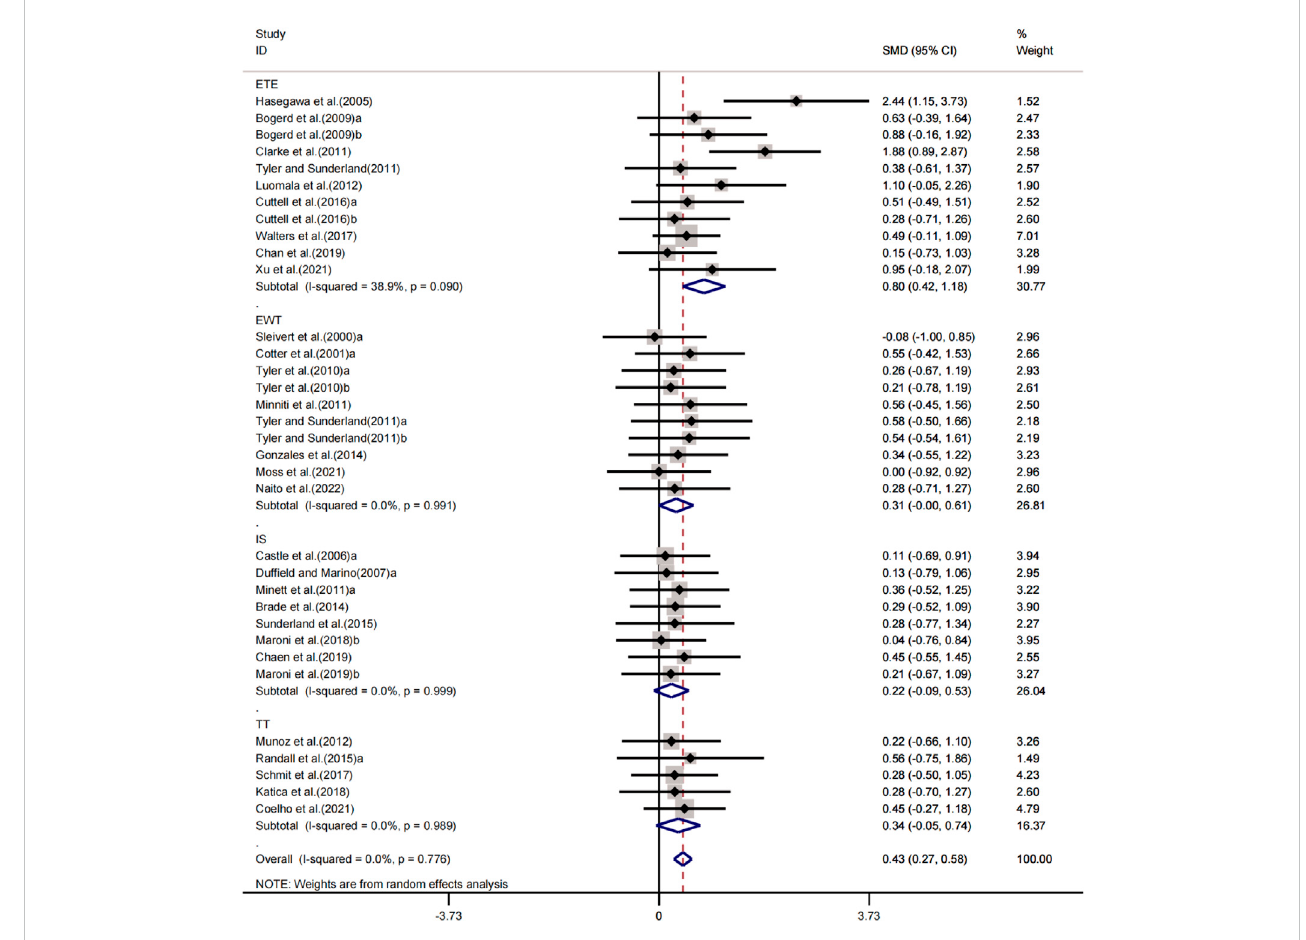
FIGURE 2 Forest plot regarding the effects of central cooling on athletic